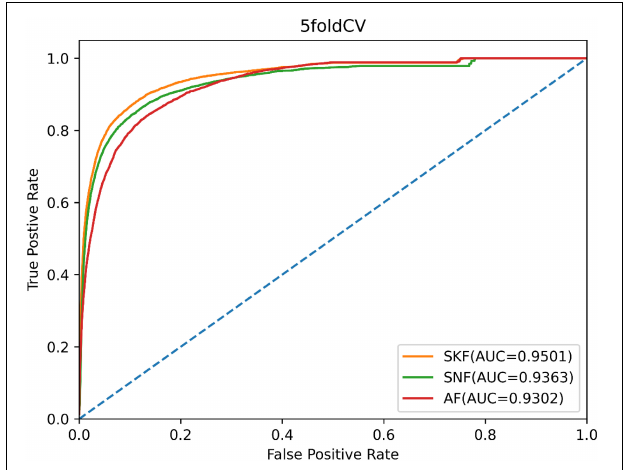
FIGURE 5 | The ROC curves of SKF, SNF, and